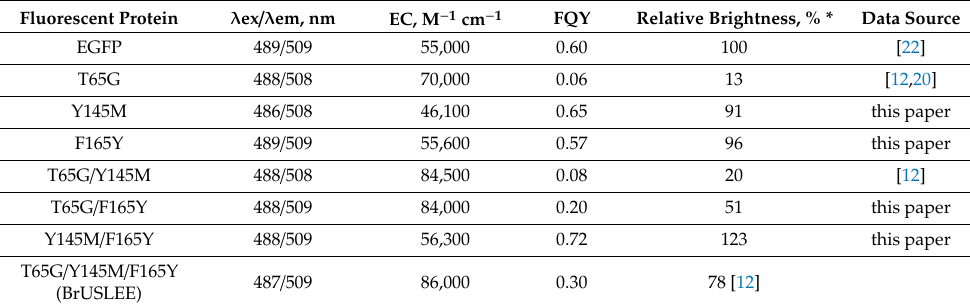
Table 1. Fluorescence brightness characteristics of the enhanced green fluorescent protein (EGFP) and its T65G, Y145M, F165Y, T65G / Y145M, T65G / F165Y, Y145M / F165Y, and T65G / Y145M / F165Y mutants. Fluorescent Protein λ ex / λ em, nm EC, M − 1 cm −